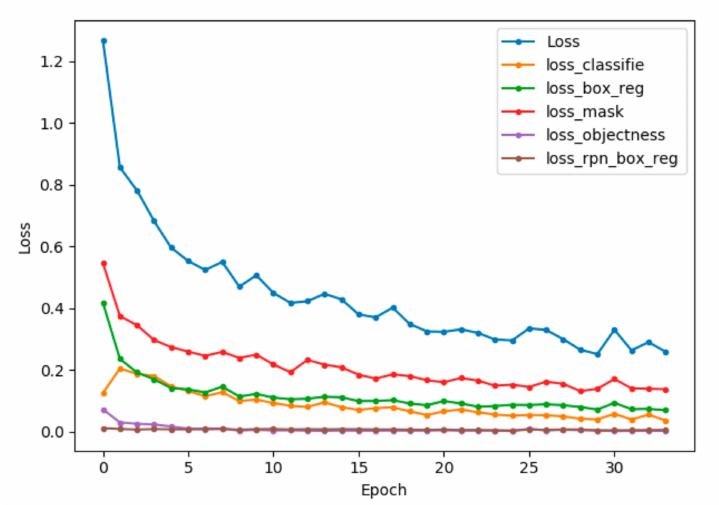
Figure 10. Performance index of the Mask-RCNN model algorithm. (Note: Loss is the total loss function of the model; loss-classifier and loss-box-reg are the rpn classification error; loss-mask is the segmentation error; loss-objectness and loss-rpn-box-reg are the model’s detection